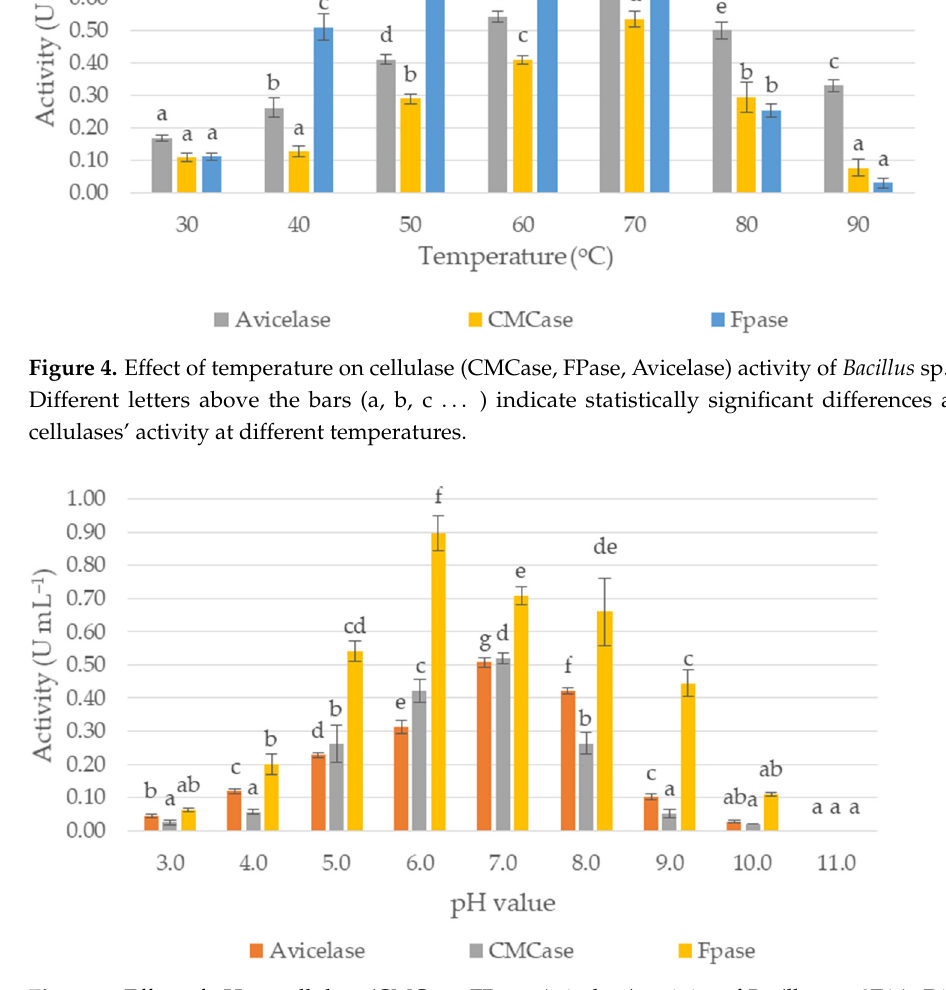
Figure 5. Effect of pH on cellulase (CMCase, FPase, Avicelase) activity of Bacillus sp. 8E1A. Different letters above the bars (a, b, c…) indicate statistically significant differences among cellulases’ activity at different pH values.